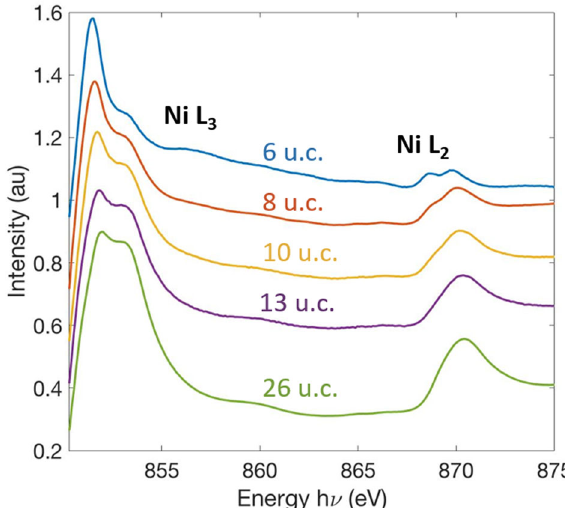
Fig. 2 X-ray absorption spectroscopy results of (111)-oriented fi lms taken at ALS beamline 6.3.1. Note that the La peak LaNiO 3 located at 849 eV has been subtracted out using peak fi tting software. Splitting of the Ni L 2 peak indicates an increased concentration of Ni 2 + ions in the LaNiO 3 fi